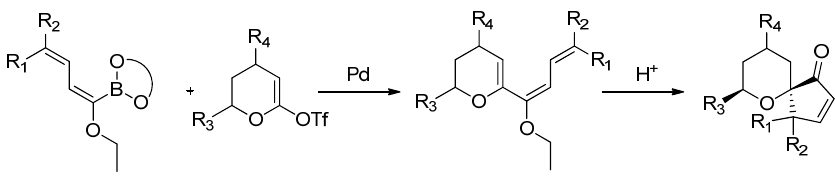
Scheme 23. Synthesis of spyrocyclic